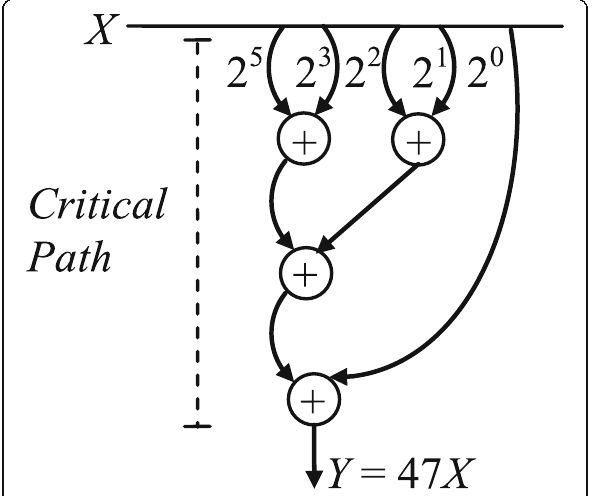
Fig. 2 Implementation structure of the product 47 X with constant 47 expressed in binary using n = 2 input